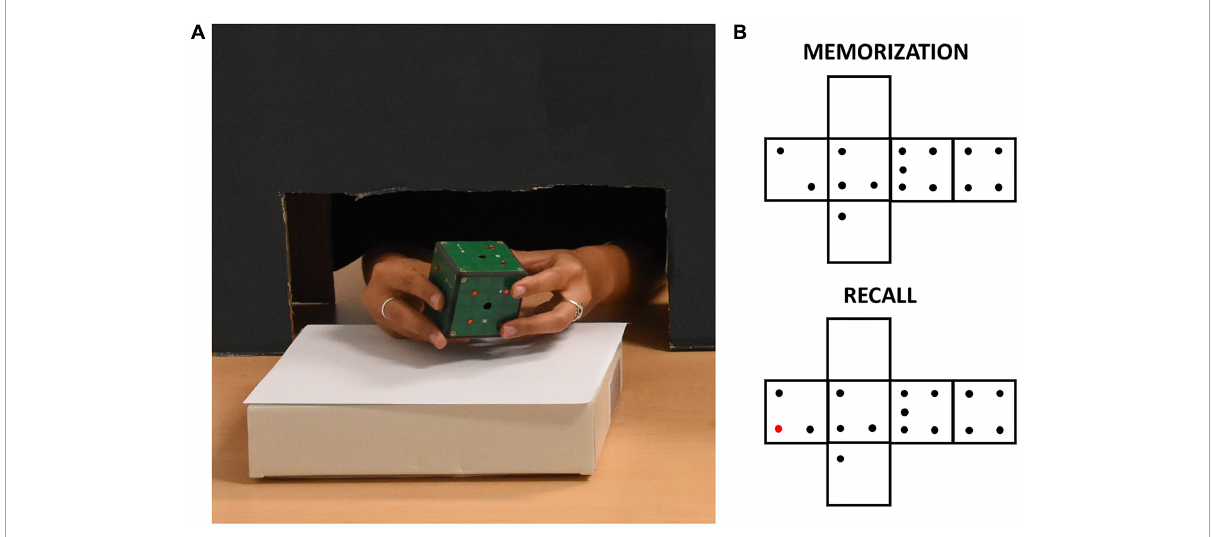
FIGURE1 (A) A participant exploring the iCube with raised red pins positioned on its faces. The black cardboard panel avoided visual inspection of the device while allowing unconstrained haptic exploration. (B) Example of pins configurations of one trial. The red pin in the recall configuration indicates the difference with respect to the memorization